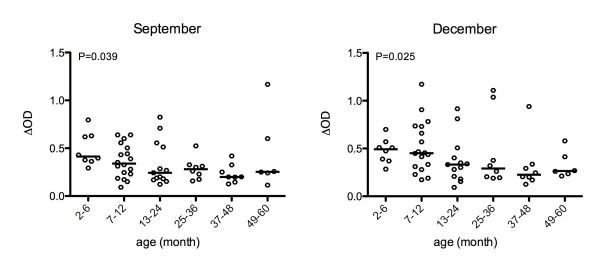
IgG response to gSG6-P1 according to age groups. Individual ΔOD in September and in December for children aged two to sixty months are presented according to age groups. Bars indicate the median value. Statistical significant differences between age groups are indicated (non-parametric Kruskal-Wallis test).